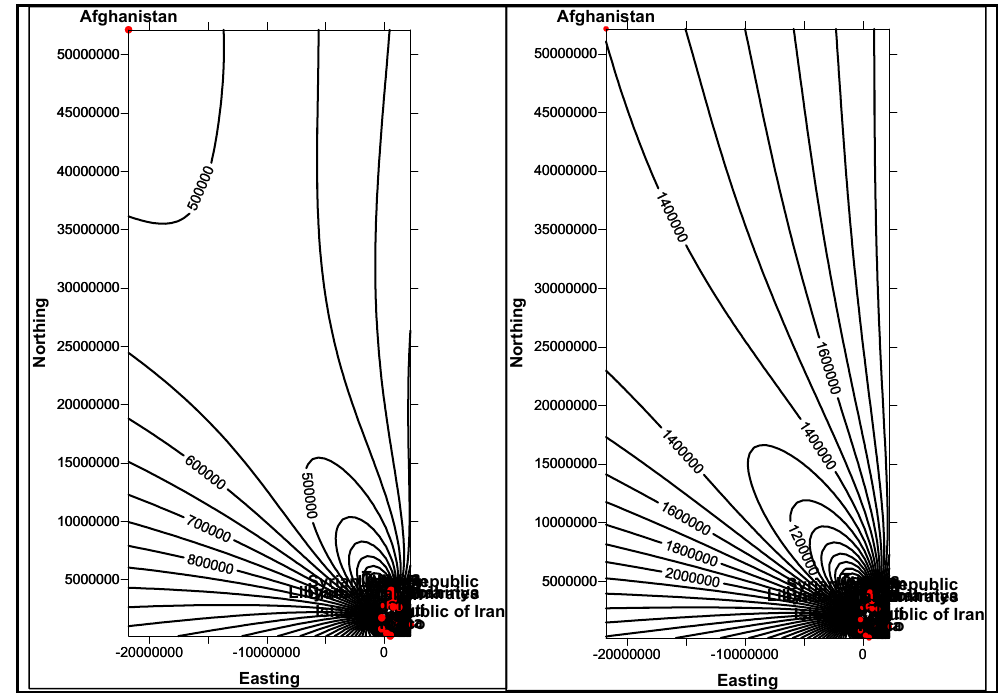
Figure 18. Map view showing diabetes reporting for Eastern Mediterranean region (for years 2000 and 2030 predictions).